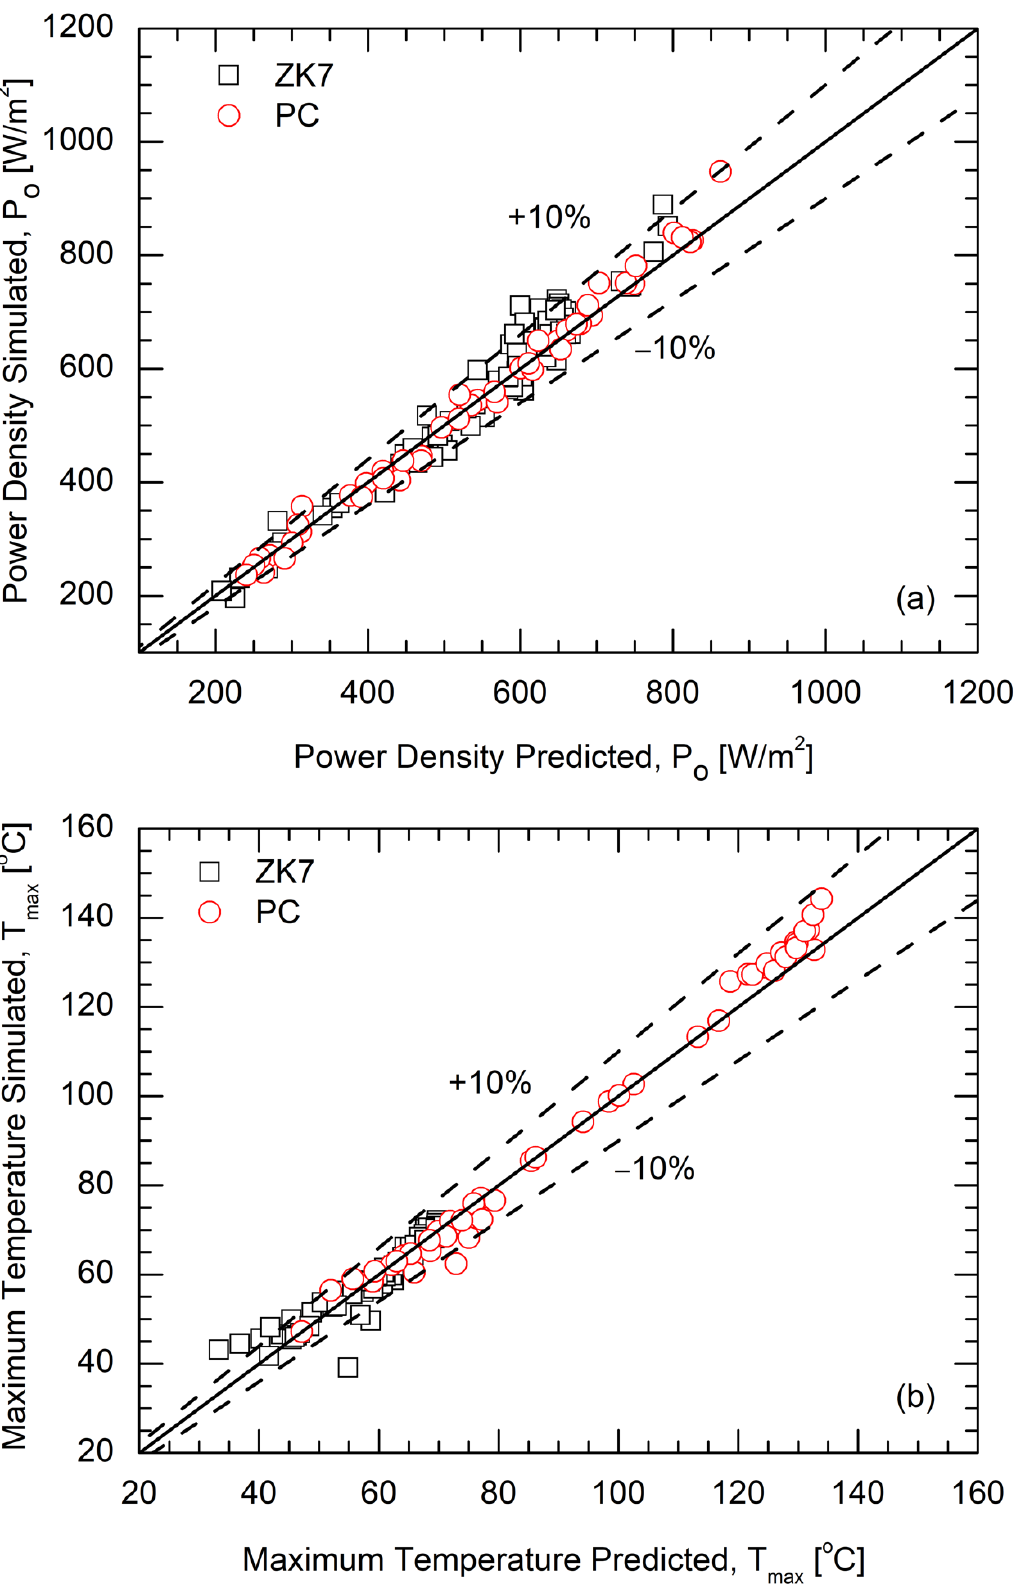
Figure 6. Comparison of numerical simulation and Taguchi correlation predicted values for ZK7 and PC waveguide material: ( a ) power density and ( b ) maximum waveguide temperature.